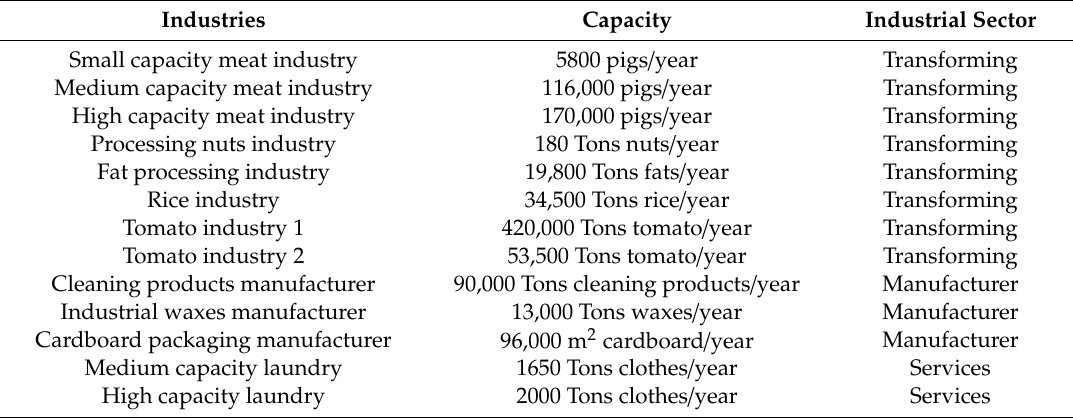
Table 1. Industries selected for the